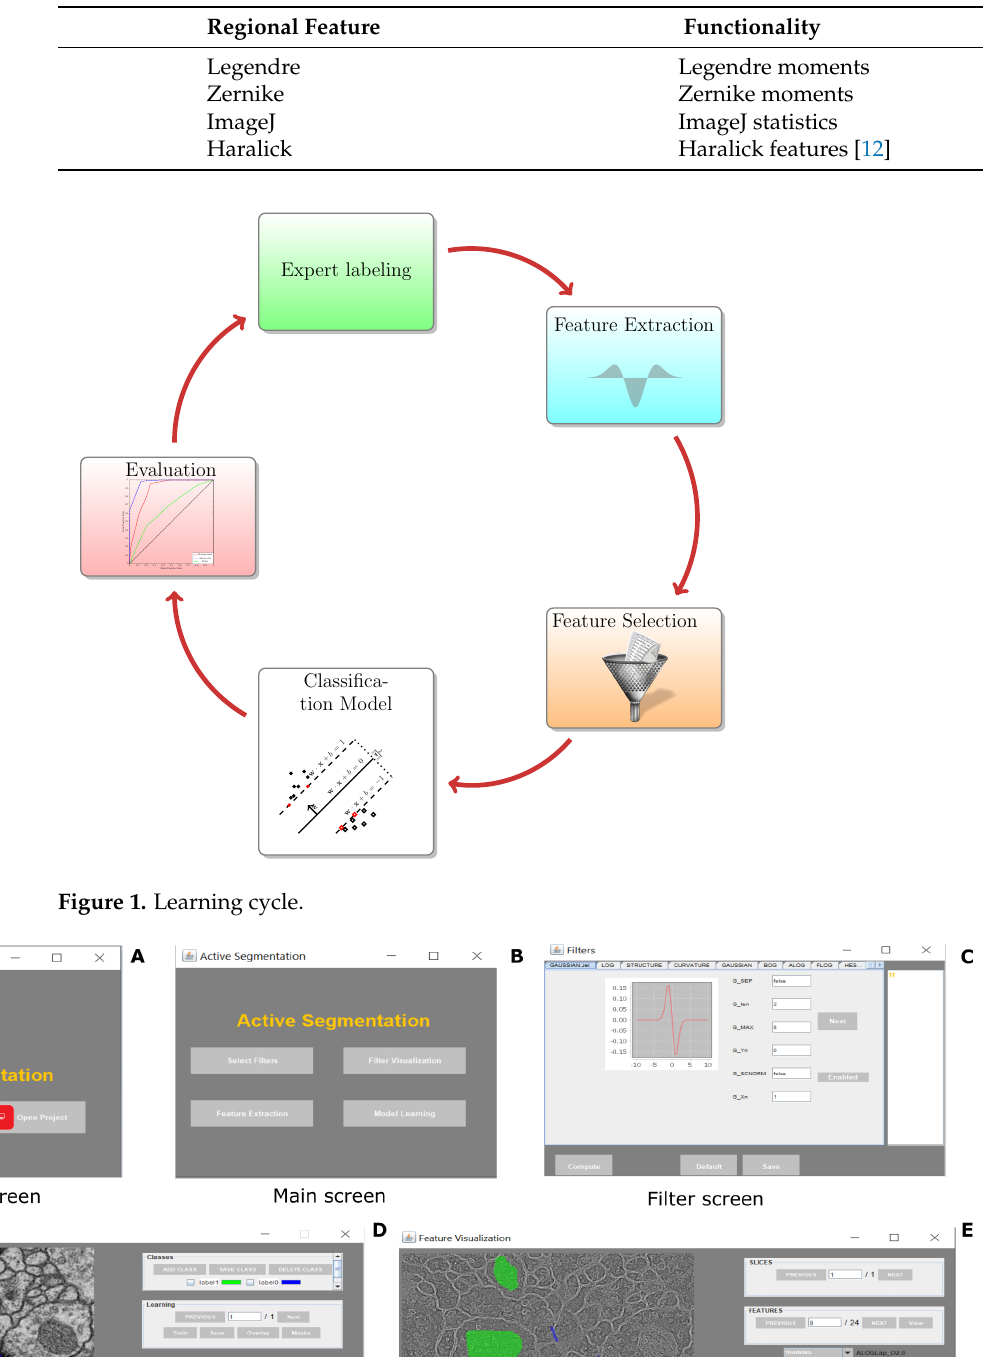
Table 4. ImageJ plugins used for computation of texture features.